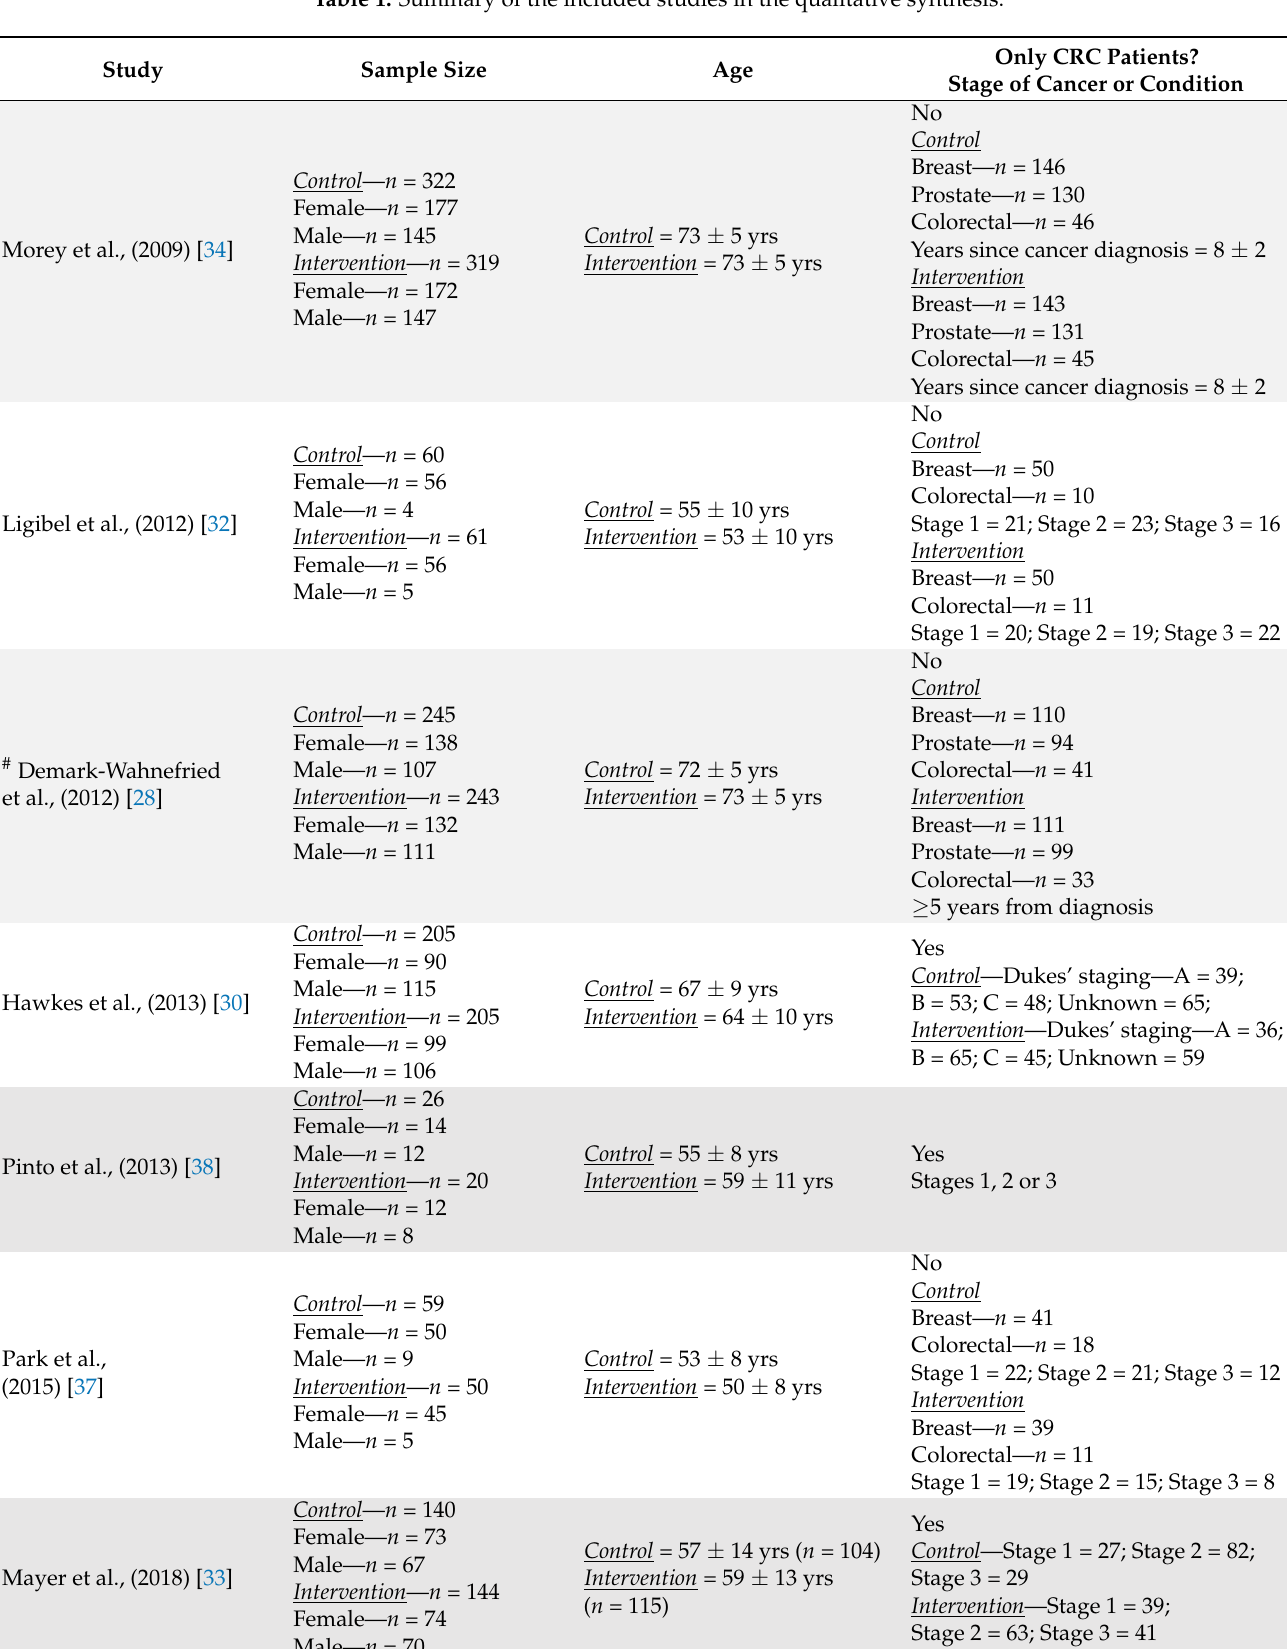
Table 1. Summary of the included studies in the qualitative